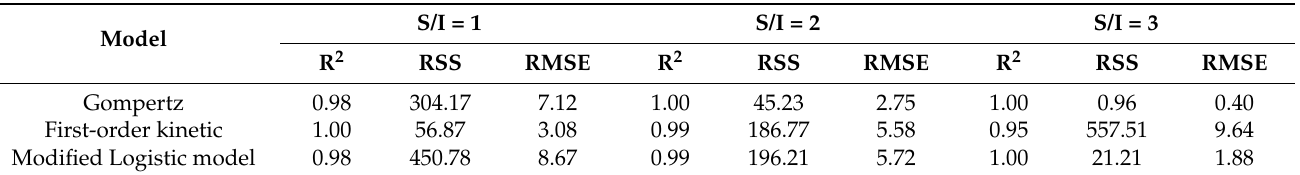
Table 6. Statistical analysis of the three compared models describing H 2 production with different substrate/inoculum (S/I) ratios.